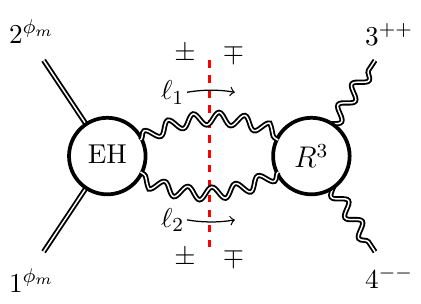
Figure 3 . The cut diagram contributing to the leading R 3 correction to gravitational scattering of a graviton (double wavy lines) off a massive scalar (double